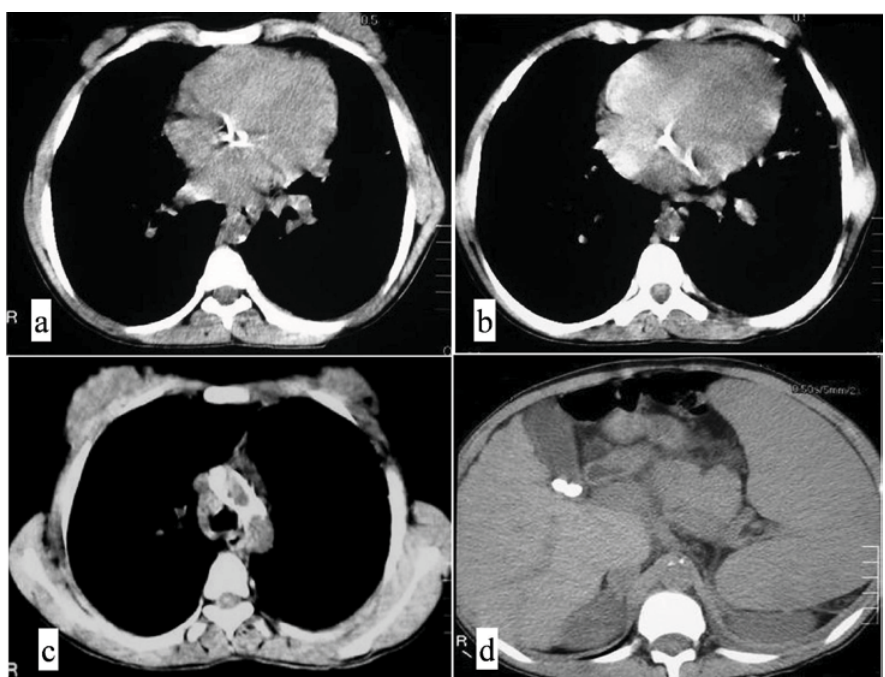
Figure 2. Axial CT images. Aortic and mitral valve calcification (a,b), aortic arch calcification (c). Two stones in the gall bladder and calcification on the descending aorta anterior wall